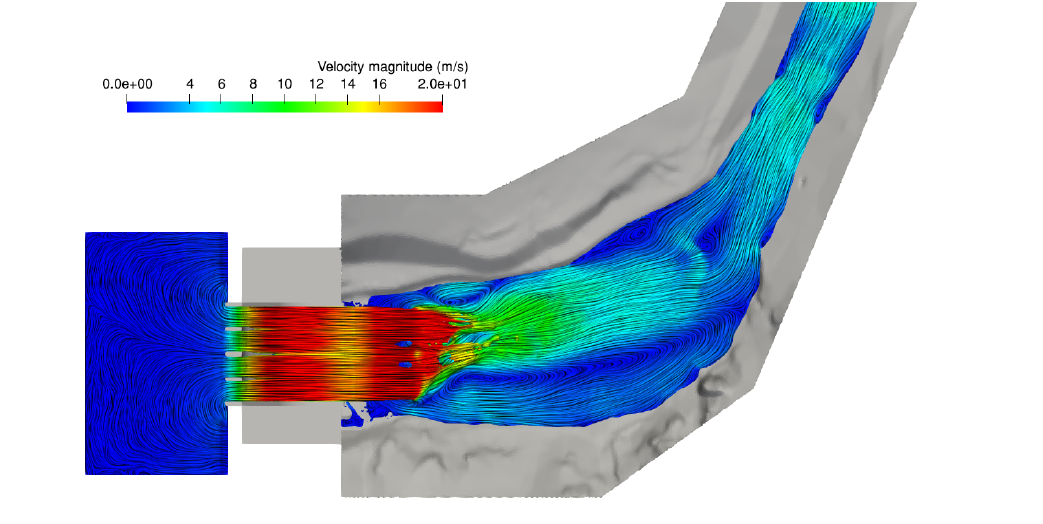
Figure 12. Visualisation of the overall water flow structure and velocity without the secondary dam at discharge flow rate of 300 m 3 /s.